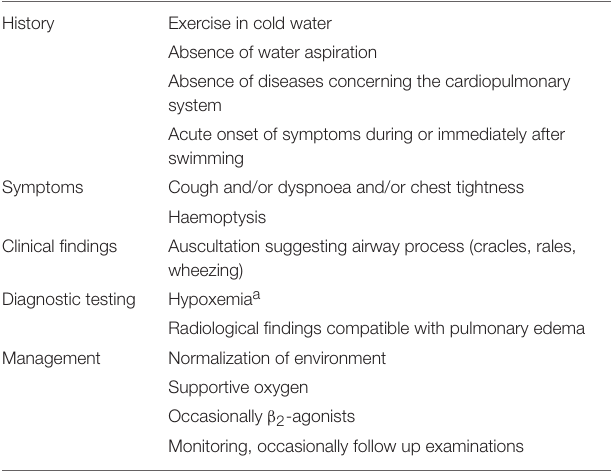
TABLE 2 | Diagnostic checkpoints and management of SIPE. History Exercise in cold water Absence of water aspiration Absence of diseases concerning the cardiopulmonary system Acute onset of symptoms during or immediately after swimming